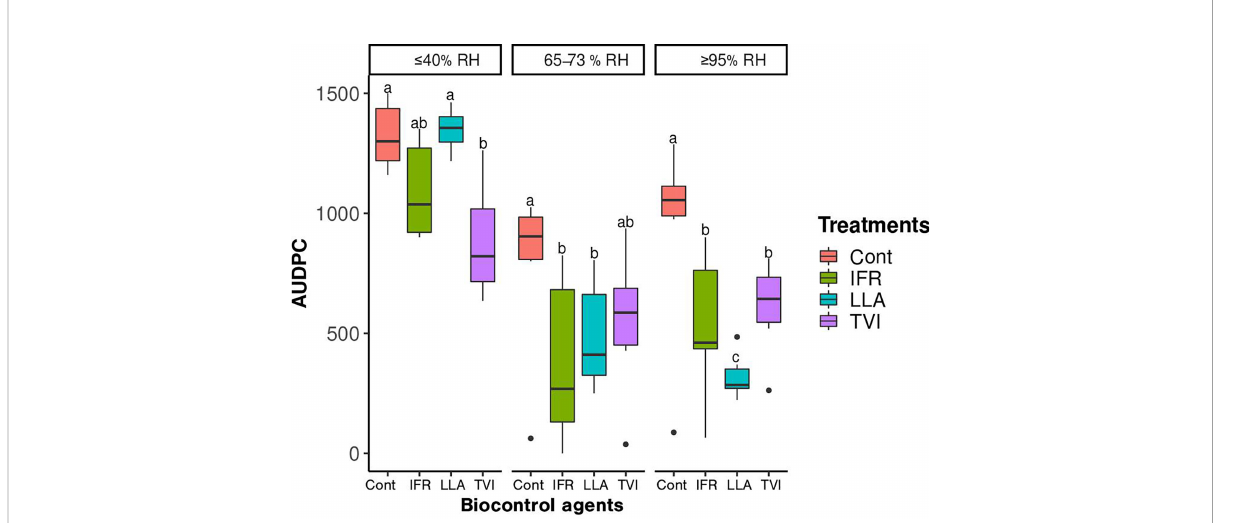
FIGURE 2 The disease progress of powdery mildew on cucumber leaves treated with microbiological agents, Lecanicillium attenuatum (LLA), Trichoderma virens (TVI), and Isaria fumosorosea (IFR), and control (Cont). The detached cucumber leaves were grown for 20 days under different relative humidity conditions, ≥ 95% RH, 65-73% RH, and ≤ 40% RH. The boxes are the mean ± SE (n = 6). The different letters indicate that values are signi fi cantly different at P< 0.05 according to the Least Signi fi cance Difference test.